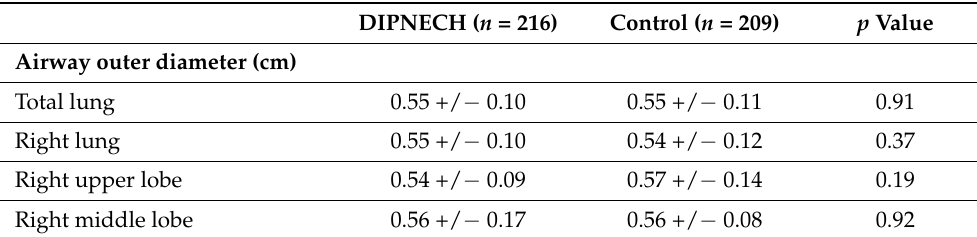
Table 2. Airway and artery diameters, wall area